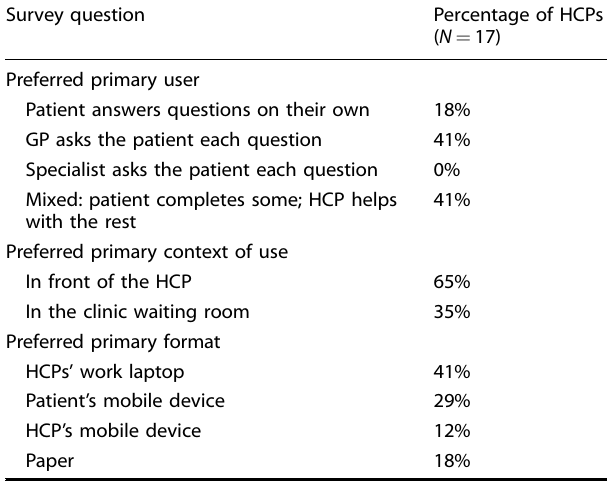
Fig. 2 HCP prioritisation of the fi ve most critical and ten other potential asthma assessment questions ( N = 17 HCPs). ER emergency room, HCPs healthcare providers, SABA short-acting β 2 Table 2. HCP survey responses about the ideal ReferID format.